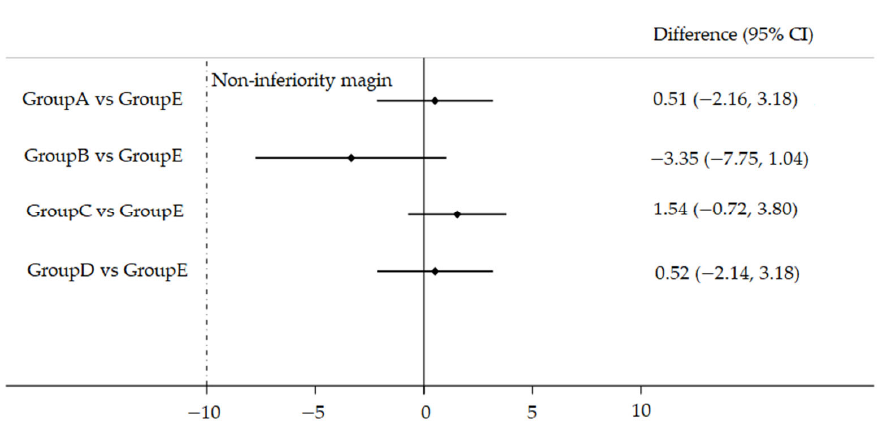
Figure 3. Differences in the proportion of seroconversion for simultaneous administration groups versus separate administration groups, China 2018 to 2019. Differences in the proportion of seroconversion were measured between simultaneous groups (Group A, Group B, Group C, and Group D) and separate group (Group E) with two ‐ sided 95% CIs.